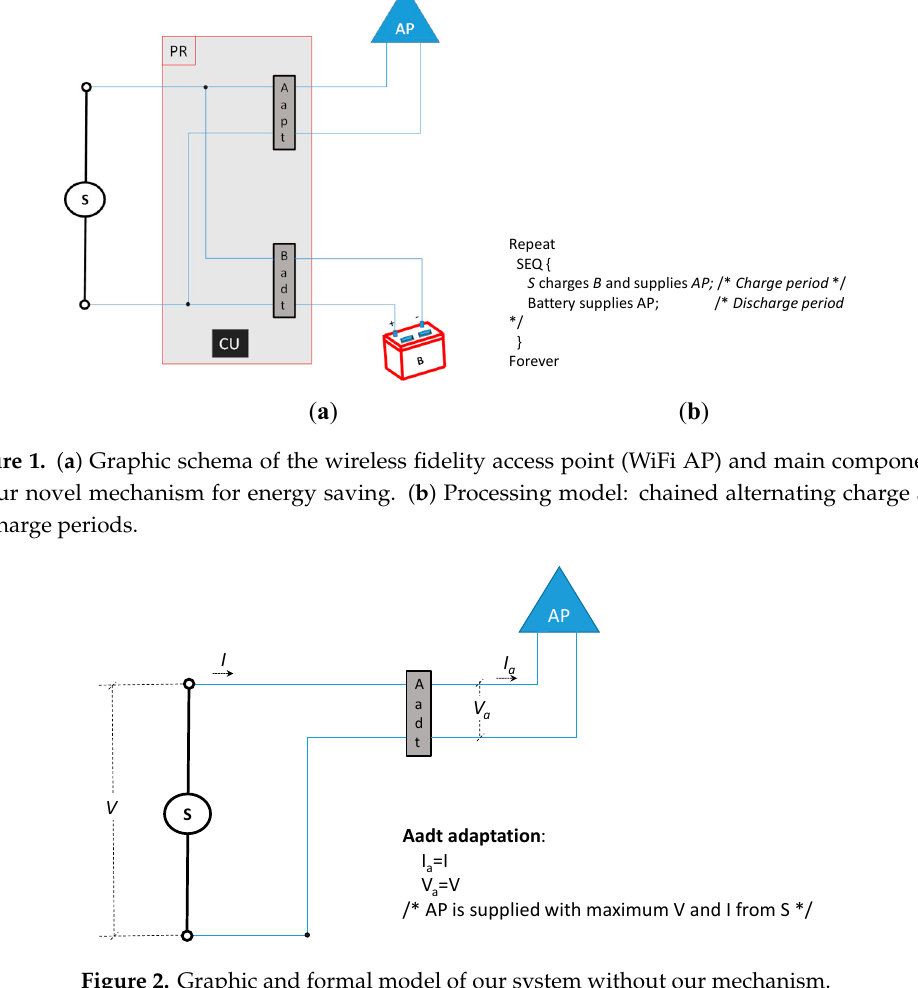
Figure 2. Graphic and formal model of our system without our mechanism.